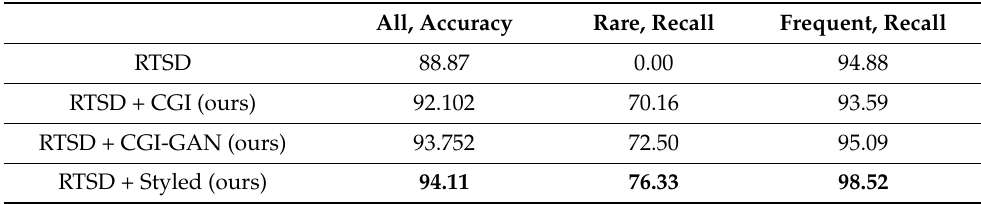
Table 1. Simple WideResNet classifier trained on a mixture of real and synthetic samples. Numbers in bold indicate the best result in the column.